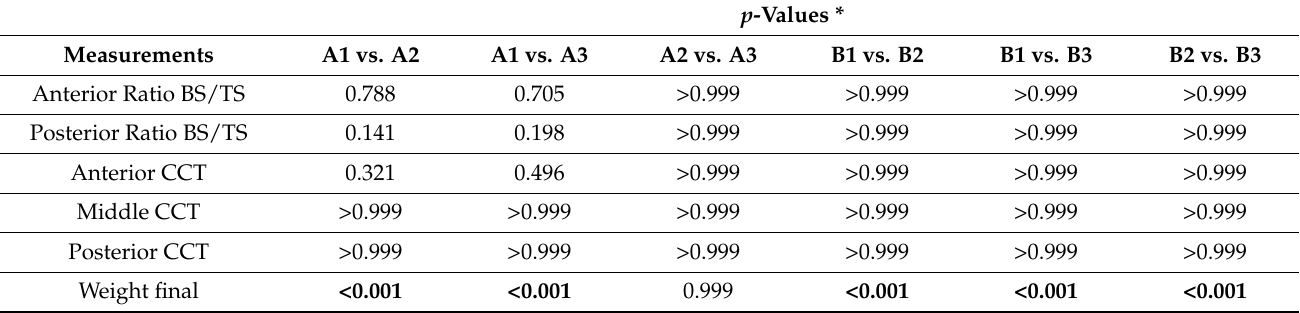
Table 7. Pairwise timing per group measurements comparisons’ p -values derived from linear regres- sion models and adjusted for multiple comparison